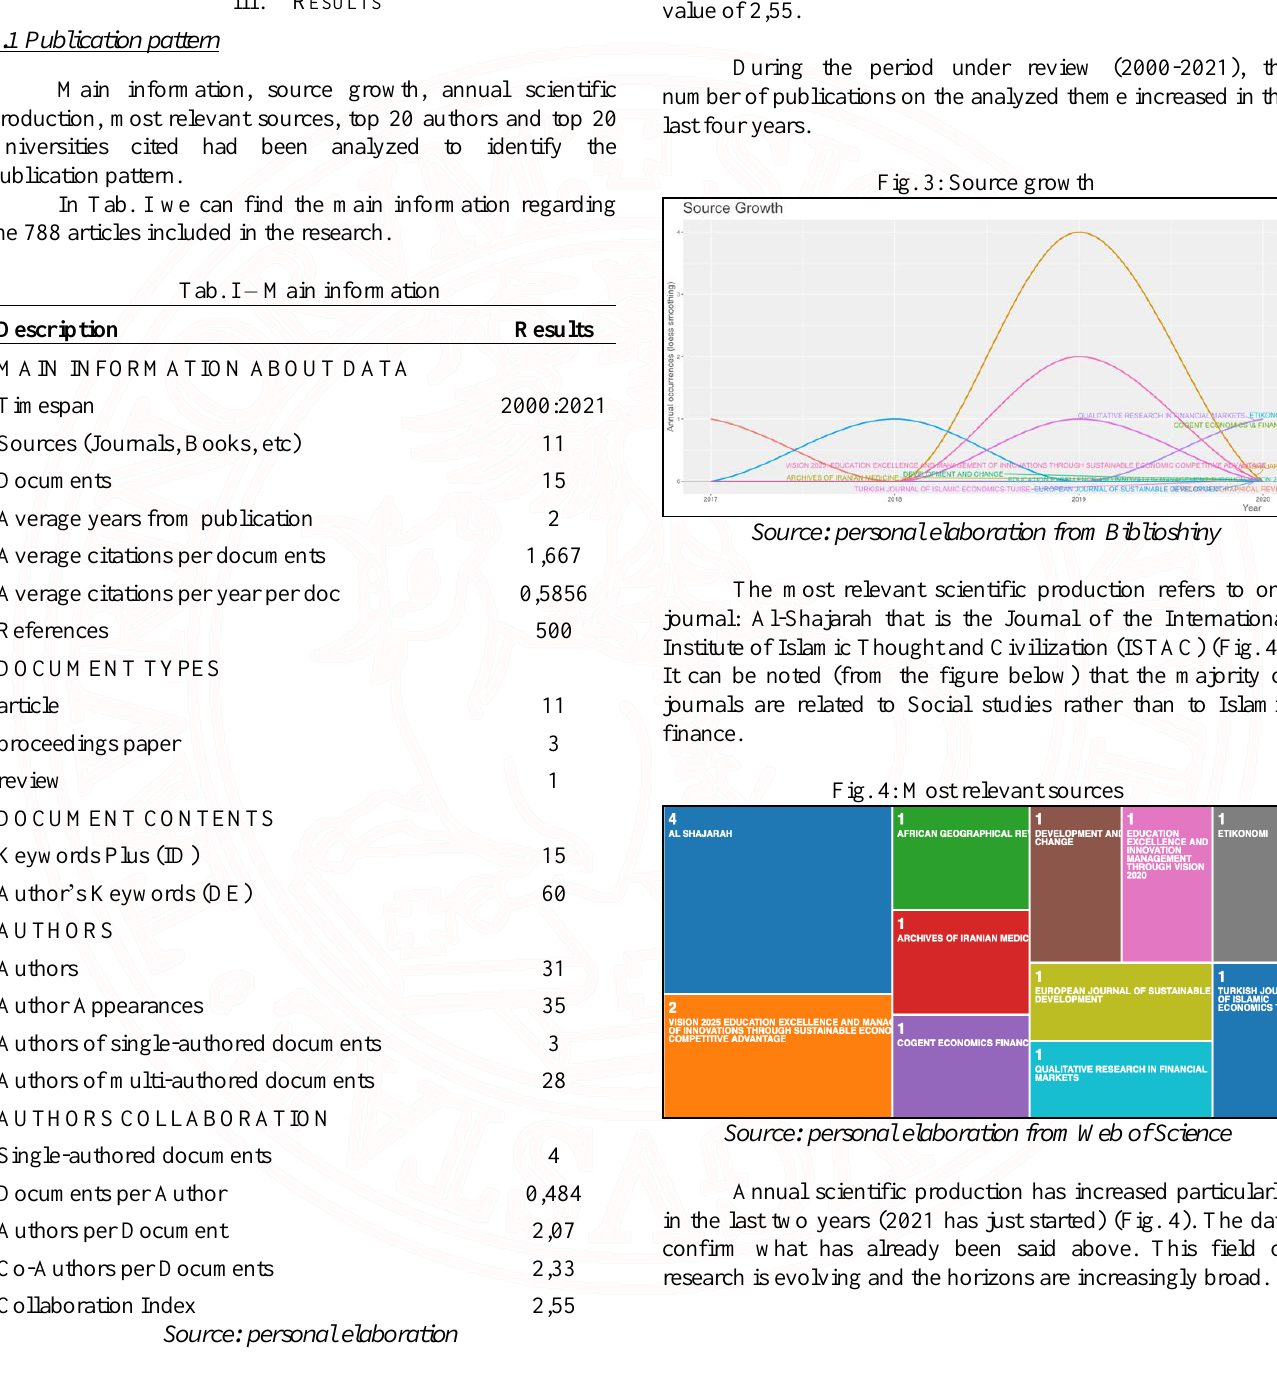
Fig. 3: Source growth